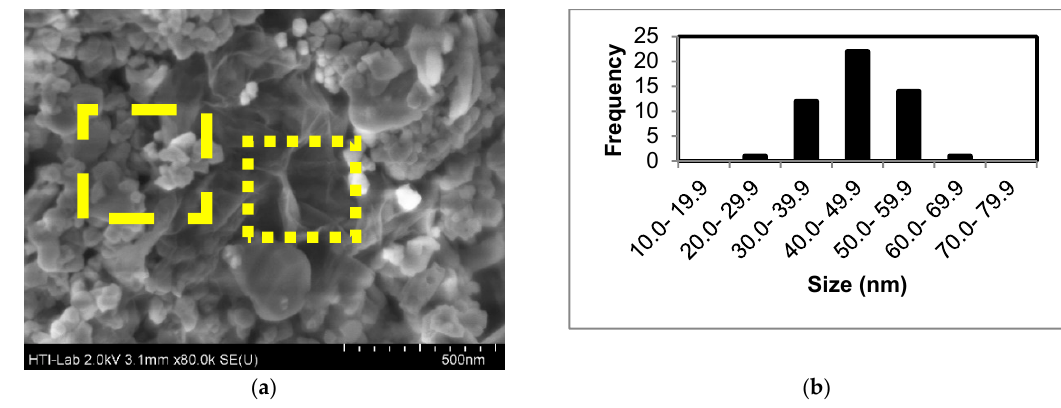
F igure 5 ( a ) FESEM image and ( b ) size distribution graph of ZnSe/GO composite synthesized with 4 Figure 5. ( a ) FESEM image and ( b ) size distribution graph of ZnSe / GO composite synthesized with M of NaOH. 4 M of